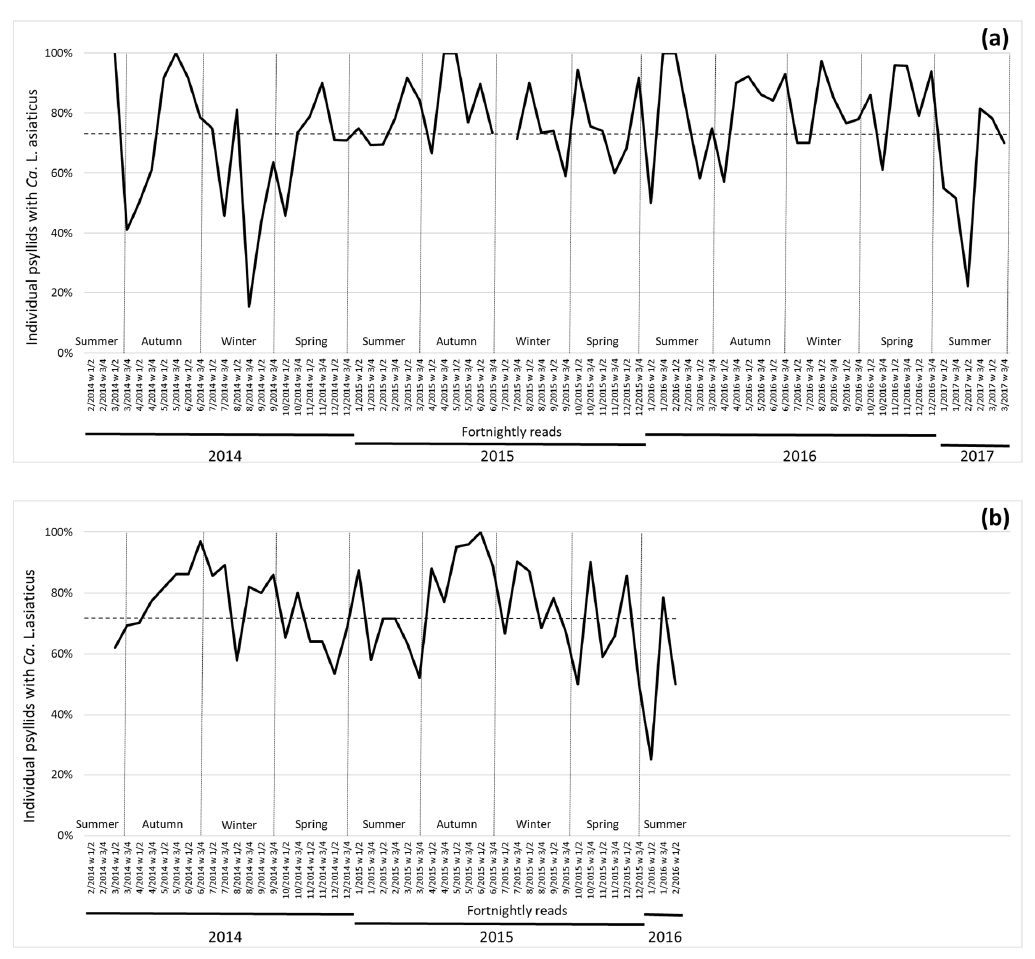
Figure 2. Percentage of psyllids carrying Candidatus Liberibacter asiaticus in fortnightly reads between February 2014 to March 2017. Dotted line indicates average Las + psyllid for the region (each time point is indicated with month/year numbering and week interval). Season indication was added to the image according to average dates from the southern hemisphere. ( a ) Avaré region (two time points are missing); ( b ) Santa Cruz do Rio Pardo region (data up to February of 2016), both in southwestern region of São Paulo state.